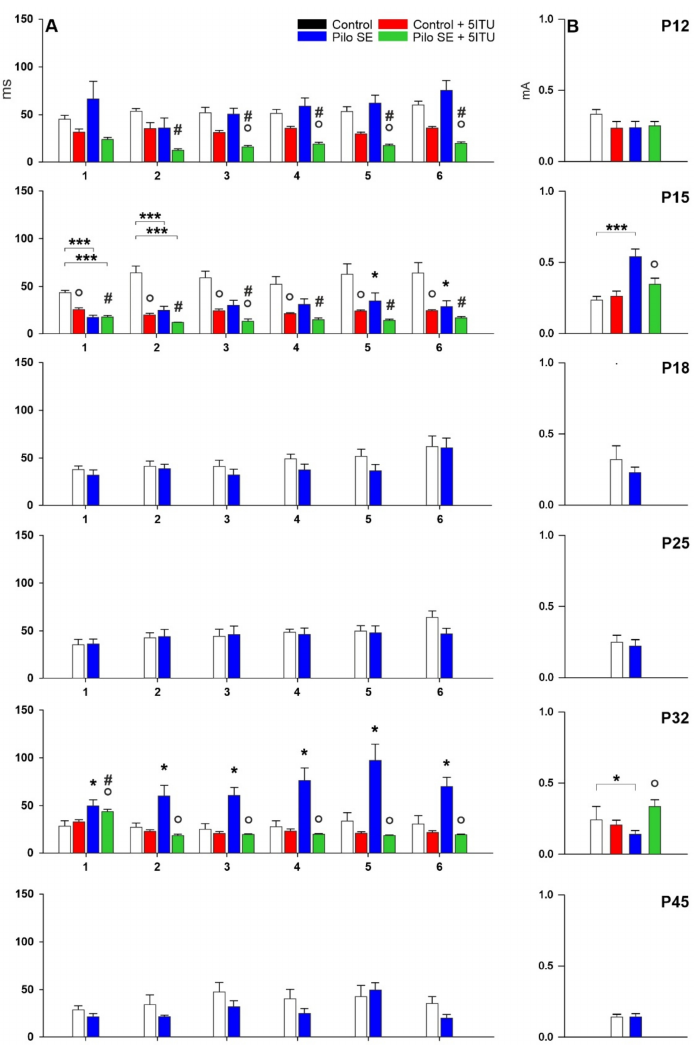
Figure 2. Effects of LiCl/pilocarpine SE, the effect of adenosine kinase inhibitor 5-ITU on the total duration of hippocampal ADs (mean + SEM), and the threshold intensity for elicitation of hippocampal afterdischarge (mean + SEM) in seven age groups. From left to right: ( A ) duration of hippocampal ADs, ( B ) threshold intensity. Black color—control rats, red color—control animals given 3.1 mg/kg of 5-ITU, blue color—LiCl/pilocarpine SE rats, green color—LiCl/pilocarpine SE rats given 3.1 mg/kg of 5-ITU (see inset). From top to bottom: 12-, 15-, 18-, 25-, 32-, and 45-day-old rats. ( A ) Abscissae: number of stimulations; ordinates: the total duration of ADs in seconds. One or three asterisks denote significant differences from corresponding control ADs for * p < 0.05 or *** p < 0.001, respectively. Circles denote significant differences from corresponding ADs in 5-ITU- pretreated rats compared to age-matched controls or SE rats for * p < 0.05. Hashtags denote significant changes from between 5-ITU-pretreated SE rats compared to age-matched controls for * p < 0.05. ( B ) Ordinates: intensity of stimulation in mA. One or three asterisks denote a significant difference from corresponding control ADs for * p < 0.05 or *** p < 0.001, respectively. Circles denote significant differences from corresponding thresholds in 5-ITU-pretreated rats compared to age-matched SE rats for * p <